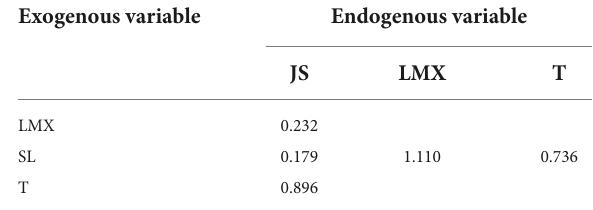
TABLE 8 Effect size ( f 2